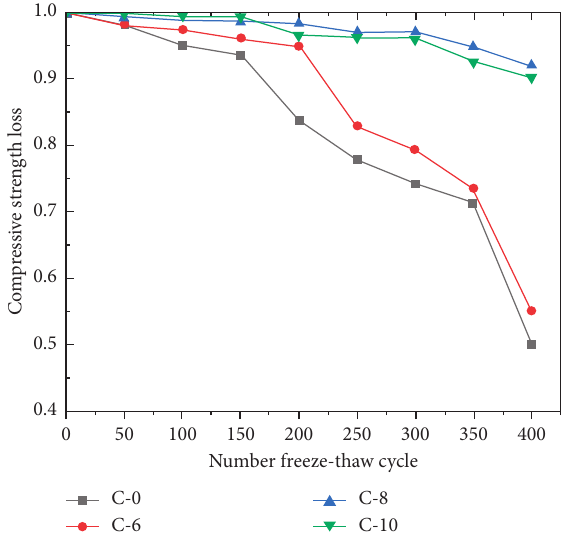
Figure 8: Compressive strength